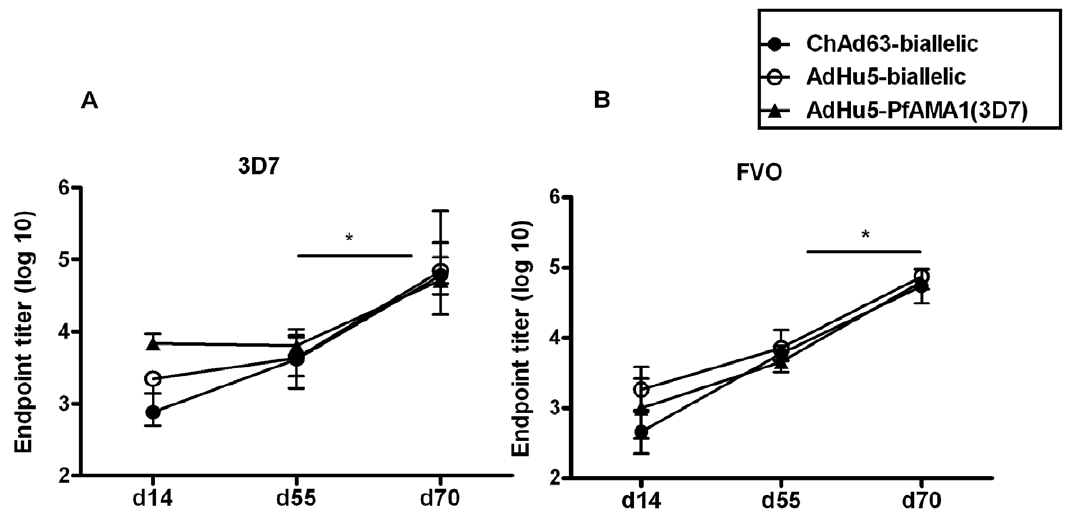
Figure 6. Antibody responses in mice induced by the mono-allelic and bi-allelic PfAMA1 vaccine constructs. 6 week old female BALB/c mice ( n =6) were primed with 1 6 10 9 vp of each of the adenovirus constructs i) ChAd63-biallelic, ii) AdHu5-biallelic and iii) AdHu5-PfAMA1 (3D7). Groups i) and ii) were boosted at day 56 with 1 6 10 7 pfu of MVA-biallelic and group iii) was boosted with the mono-allelic MVA-PfAMA1 (3D7). The total IgG response was measured by ELISA in the serum at day 14, 55 and 70 against both the 3D7 (A) and FVO (B) alleles. The median and the range of the endpoint titer (log 10) are shown in the figure. There were significant differences between the ELISA titres at day 14 by one-way ANOVA: 3D7 PfAMA1 ChAd63-biallelic versus AdHu5-monoallelic P , 0.001; FVO PfAMA1 ChAd63-biallelic versus AdHu5-biallelic P , 0.05. The MVA boost significantly increased IgG titres against both alleles in all groups (* P , 0.05 by Wilcoxon signed rank test).